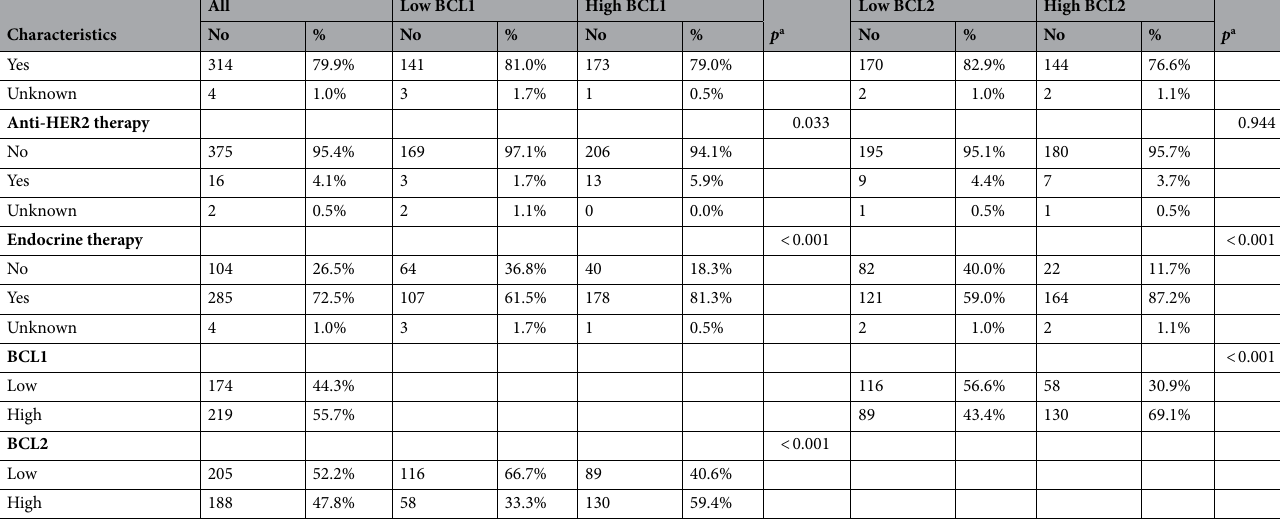
Table 1. Baseline characteristics of study subjects according to BCL1 and BCL2 statuses. HER2 human epidermal growth factor receptor 2, HRc hormone receptor. a P value for mean age was calculated by t -test and all the other p values were calculated by χ 2 test.